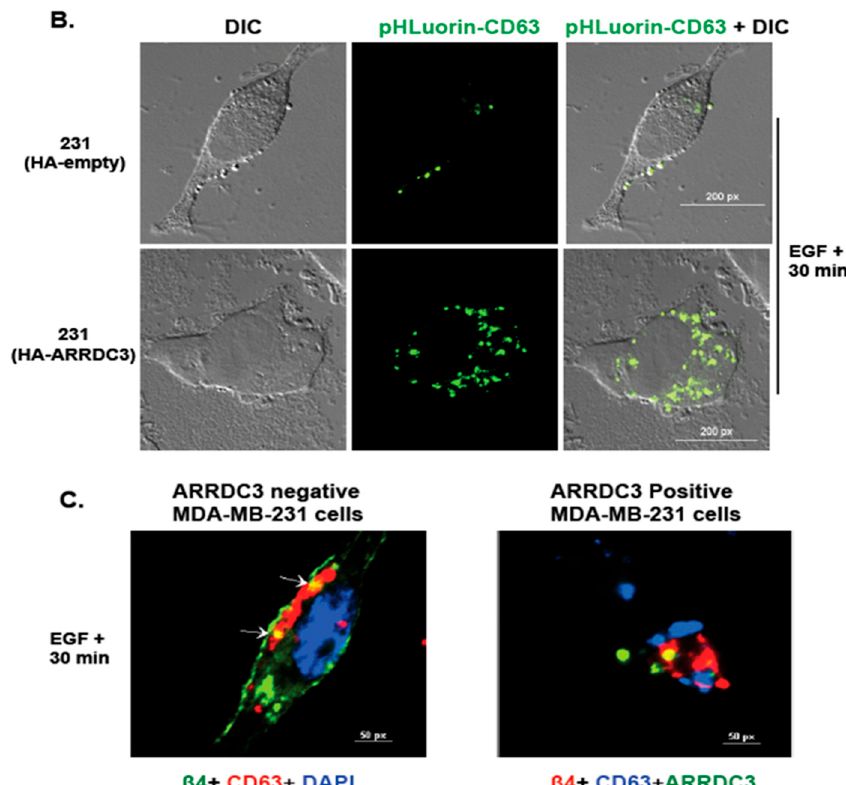
Figure 6. ARRDC3 prevents EGF-driven fusion of CD63 positive EVs at plasma membrane. ( A ) Immunofluorescence images show CD63 (red) and ARRDC3 (green) localization and DAPI nuclear staining (blue) in MDA-MB-231 cells with or without GFP-ARRDC3 for the time course with EGF treatment. Scale bar: 20 µ m. ( B ) HA and HA-ARRDC3 expressing MDA-MB-231 cells were transfected with pHLuorin-CD63 (green) which is quenched at low pH (late endosomes) and bright at neutral pH (extracellular space or early endosome). Upon EGF treatment, CD63 location was captured by fluorescence microscope. ( C ) Immunofluorescence images show CD63 and ITG β 4 localization in ARRDC3 positive and negative MDA-MB-231 cells at 30 min of EGF treatment (CD63; red, ITG β 4; green, DAPI; blue: bottom left and CD63; blue, ITG β 4; red, ARRDC3; green: bottom right). Scale bar: 50 µ m. Representative images were selected from three independent experiments.